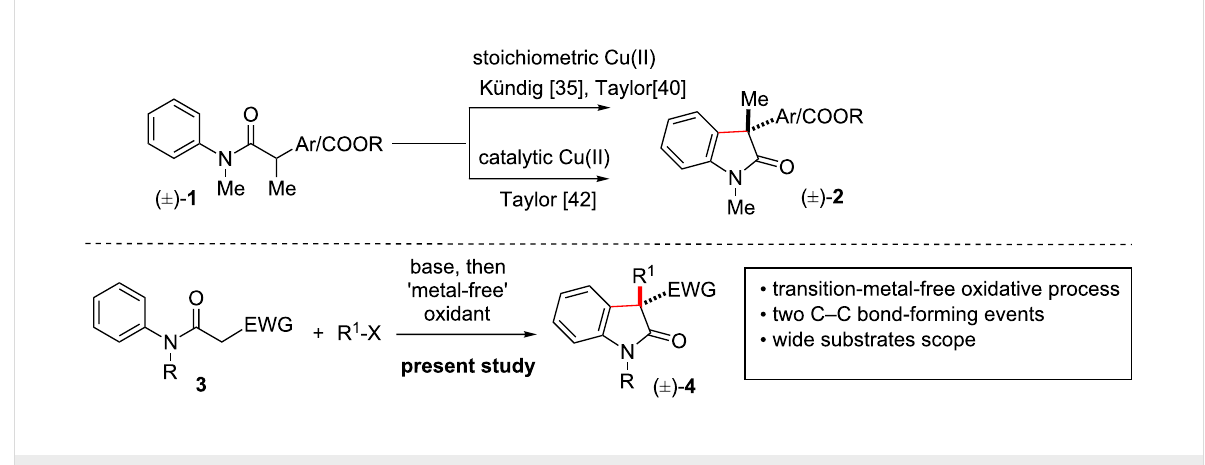
Scheme 1: Synthesis of 2-oxindoles via oxidative